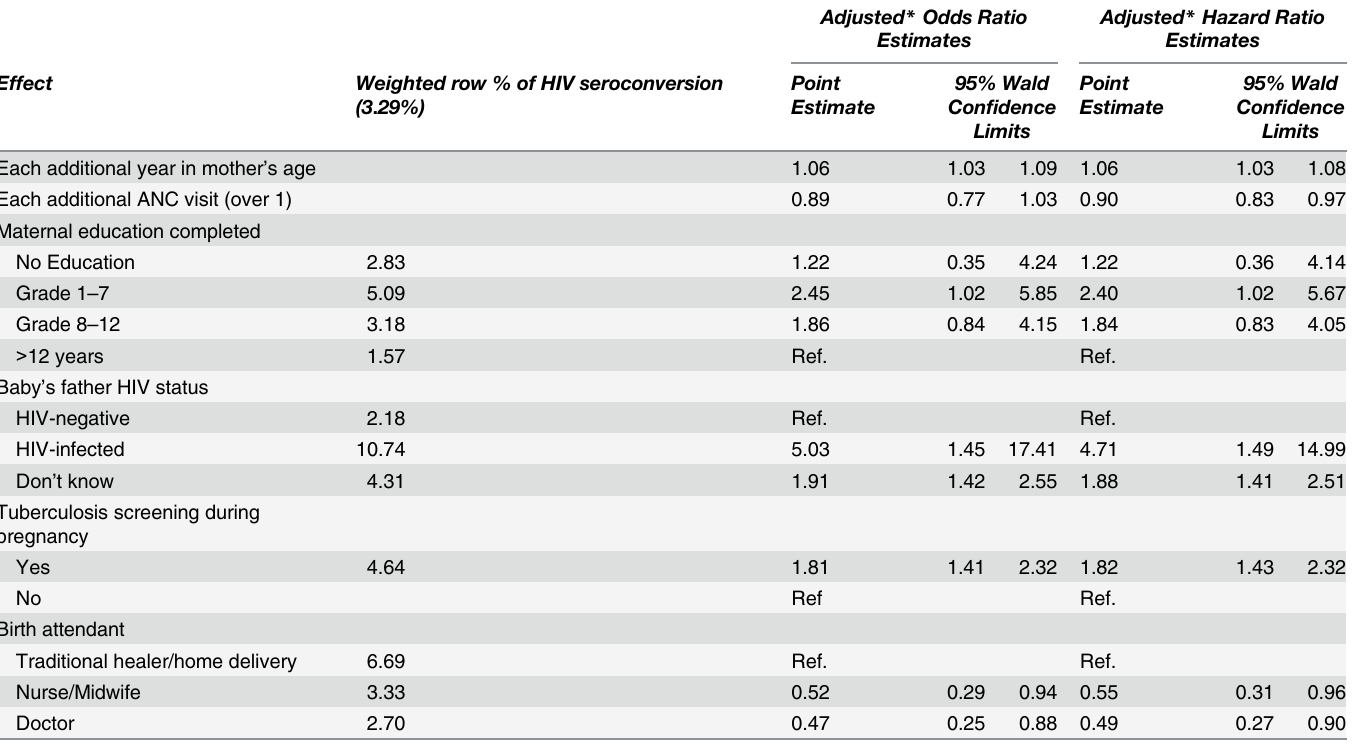
Table 2. Weighted risk factors of the maternal HIV seroconversion during pregnancy, South Africa, 2011 – 2012 (Reduced multivariate